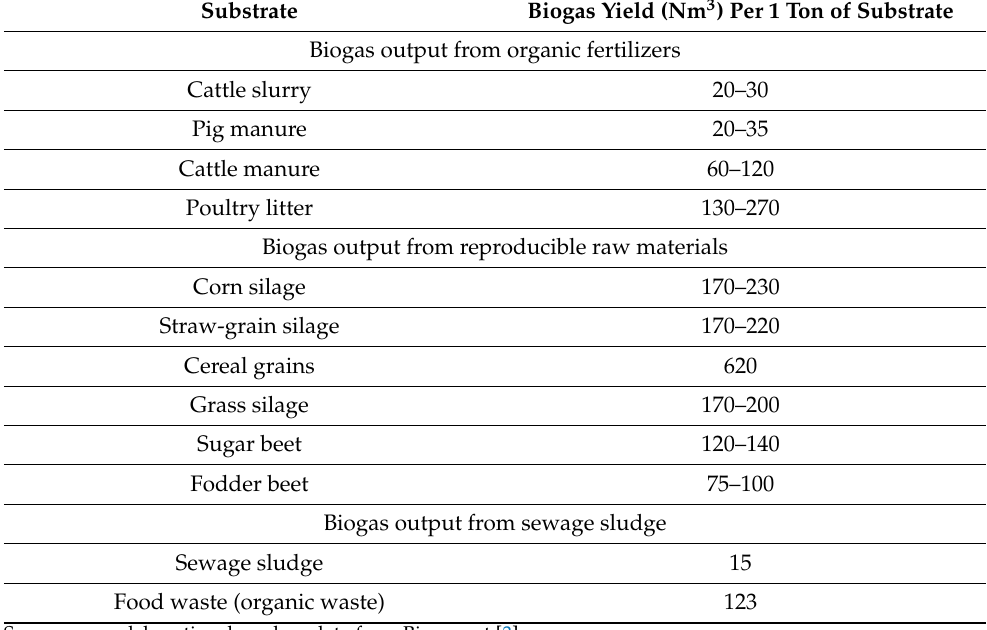
Table 2. Biogas yield from different types of raw